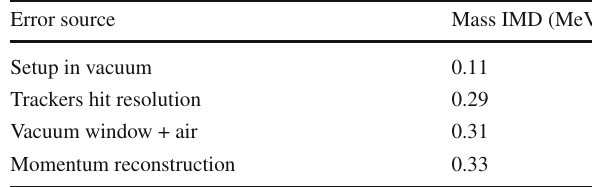
Table 5 Width of the invariant mass distribution after different error contributionsareaddedcumulativelytothesimulation.Inthefirstentry, all the space in the decay volume is substituted by perfect vacuum, the only material left is the one of the trackers and the W2. In the second entry, a 80 µ m hit resolution is added to the trackers. In the third entry, the vacuum is substituted by the realistic setup shown in Fig. 11. Finally, the last entry add the effect of the momentum reconstruction. The invariant mass distribution with all effects considered is presented in Fig.